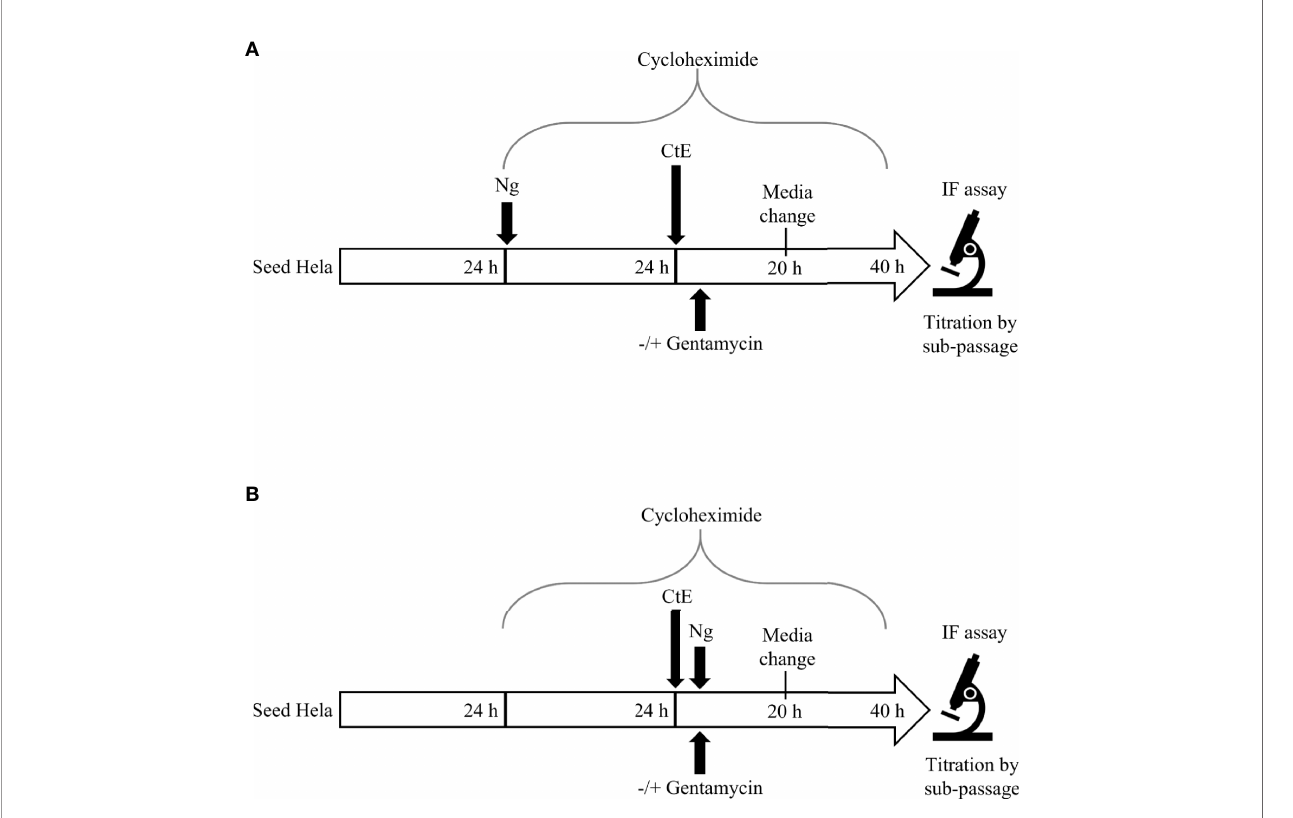
FIGURE 1 | Experimental Design. For Ng pre-infection (A) , 24 h after seeding in 24 well plates, HeLa cells were infected with Ng in cycloheximide-supplemented culture medium for 24 h prior to subsequent CtE infection. Immediately after CtE infection, inocula were replaced with fresh cycloheximide-supplemented culture medium without gentamycin, to allow continued Ng growth ( Figure 2 ), or with gentamycin, to restrict further Ng growth ( Figure 4 ). For Ng infection after CtE infection (B) , 24 h after seeding in 24 well plates, HeLa cells were exposed to cycloheximide-supplemented culture medium (no Ng) for 24 h prior to subsequent CtE infection. Immediately after CtE infection, inocula were replaced with Ng in fresh cycloheximide-supplemented culture medium without gentamycin, to allow Ng growth ( Figure 3 ), or with gentamycin, to restrict Ng growth ( Figure 5 ). In both experimental settings (A, B) , cycloheximide-supplemented medium was refreshed at 20 h post CtE infection, with gentamycin concentrations maintained, and samples were processed for IF analysis of inclusion development/formation or determination of infectivity (IFU/well) at 40 h post-CtE